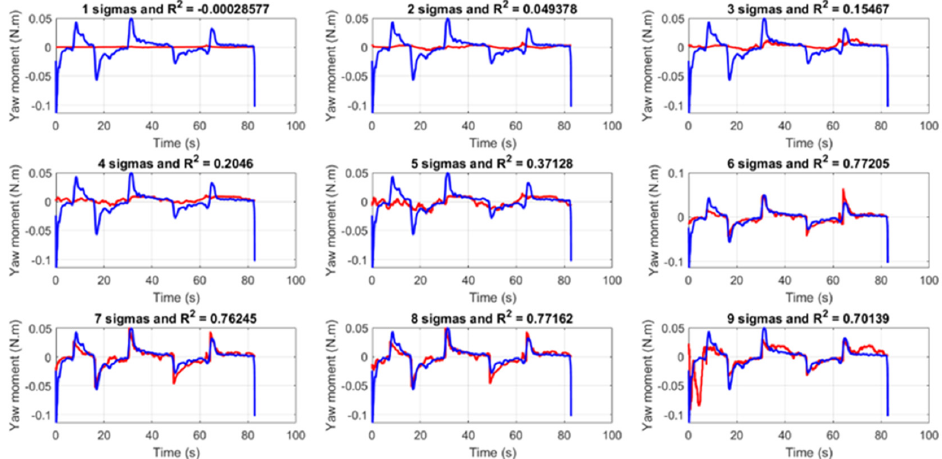
Figure 14. Results from the validation for yaw motion with 20°–20° zigzag manoeuvre tests’ data.